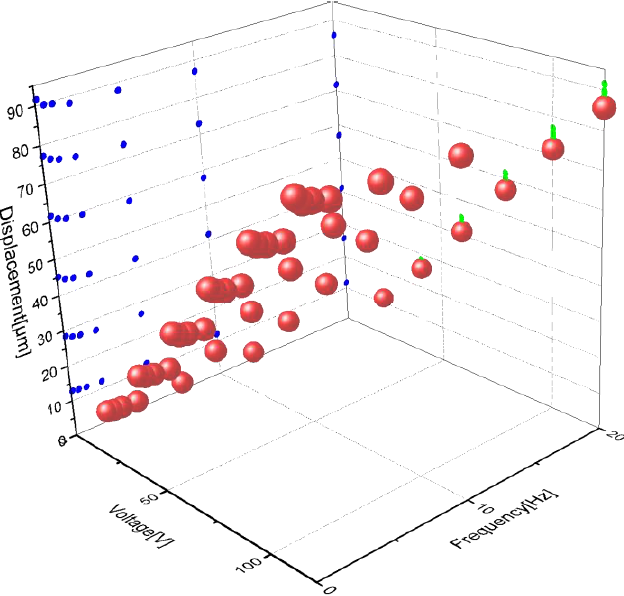
Figure 5. Peak Displacement on variable voltages.